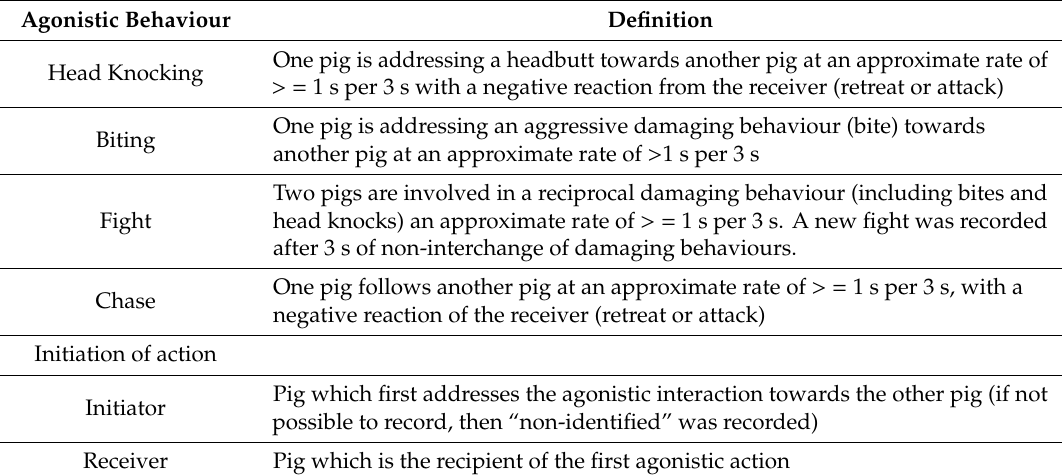
Table 1. The ethogram used to record the agonistic behaviour (adapted from Turner et al., 2006